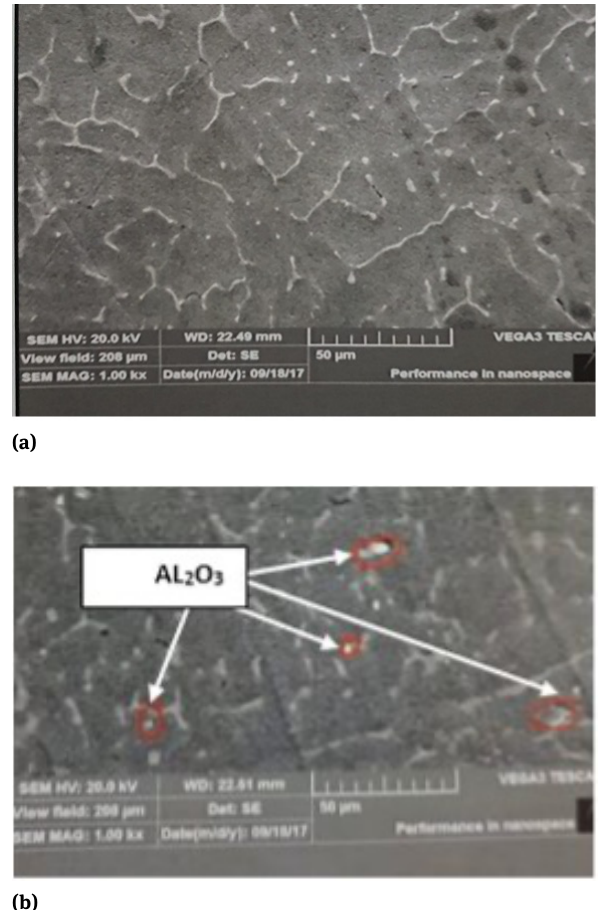
Figure 9: Matrix and composites microstructure (a) zero nano-Al 2 O 3 (b) 9 wt% nano-Al 2 O